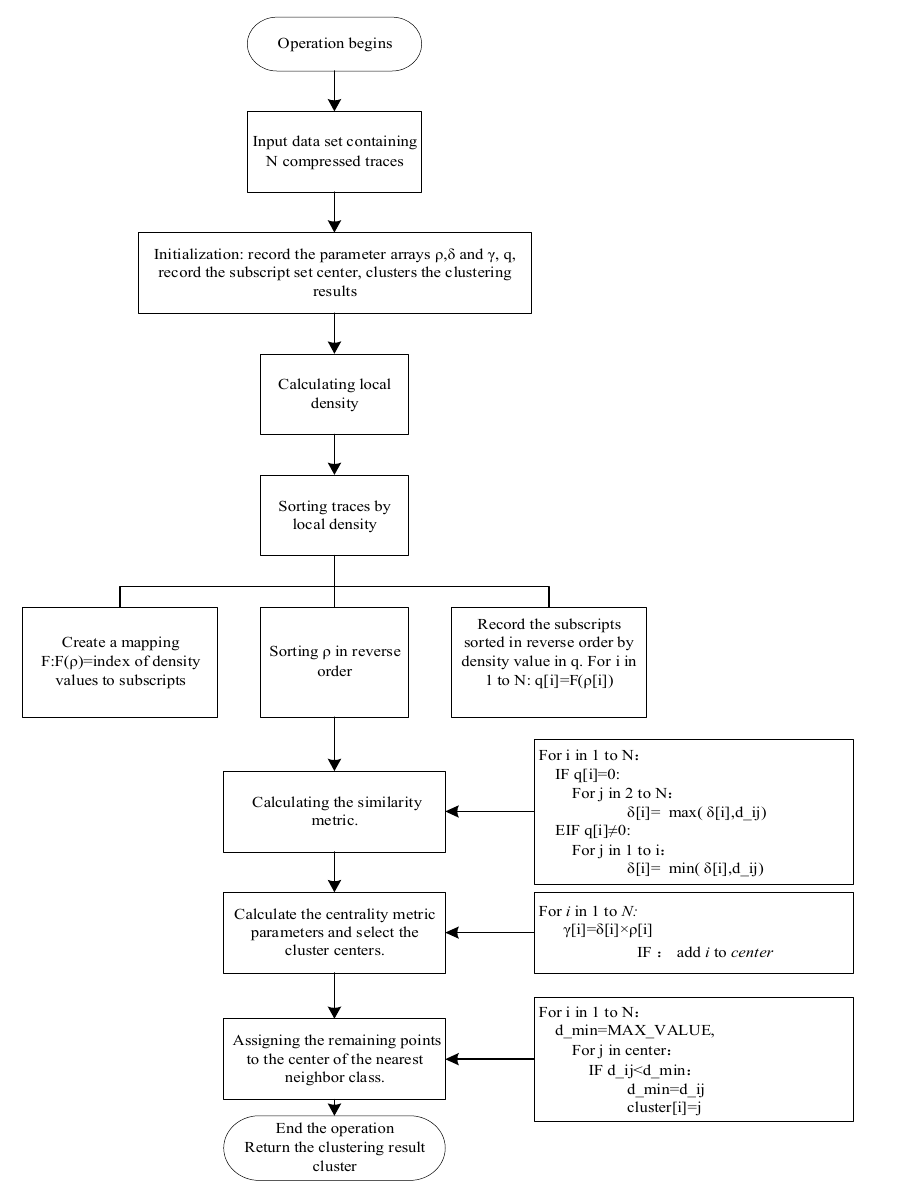
Figure 9. The flow chart of the